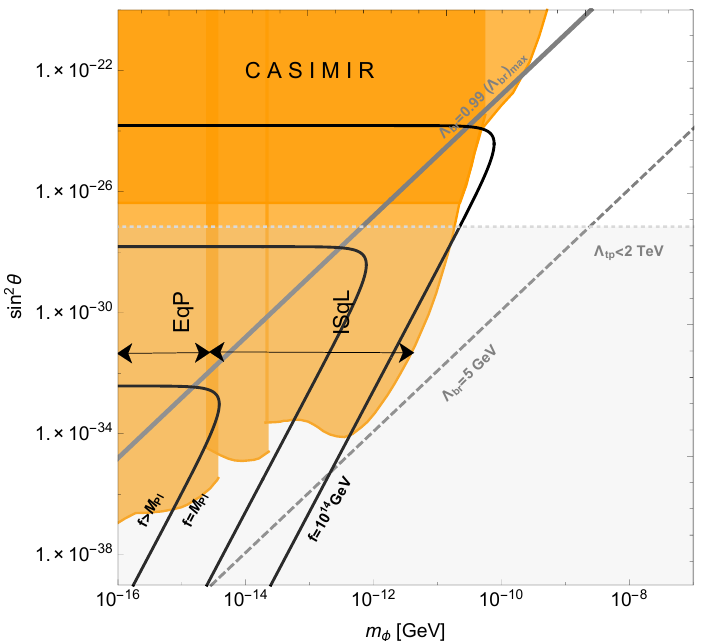
Figure 2 . Constraints on the relaxion-Higgs mixing sin 2 (cid:18) for light relaxions with m (cid:30) between 10 (cid:0) 16 GeV and 10 (cid:0) 7 GeV. Fifth-force experiments (orange) probe the lightest mass range via the equivalence principle (labelled as EqP), the inverse square law (ISqL) and the Casimir ef- fect (Casimir). Contours of constant (cid:3) br (gray) for (cid:3) br = 0 : 99(cid:3) max solid) and (cid:3) br = 5 GeV (gray, dashed). Here (cid:3) max